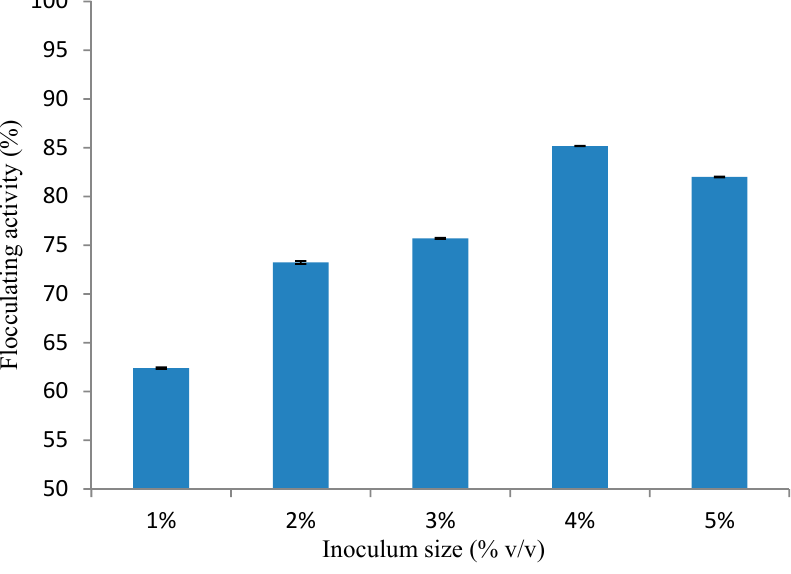
Figure 1. Effect of Inoculum Size on Bioflocculant Production by Bacillus sp.